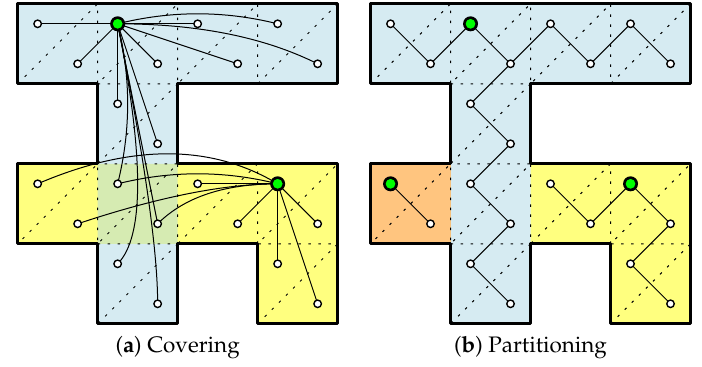
Figure 8. Difference between covering and partitioning